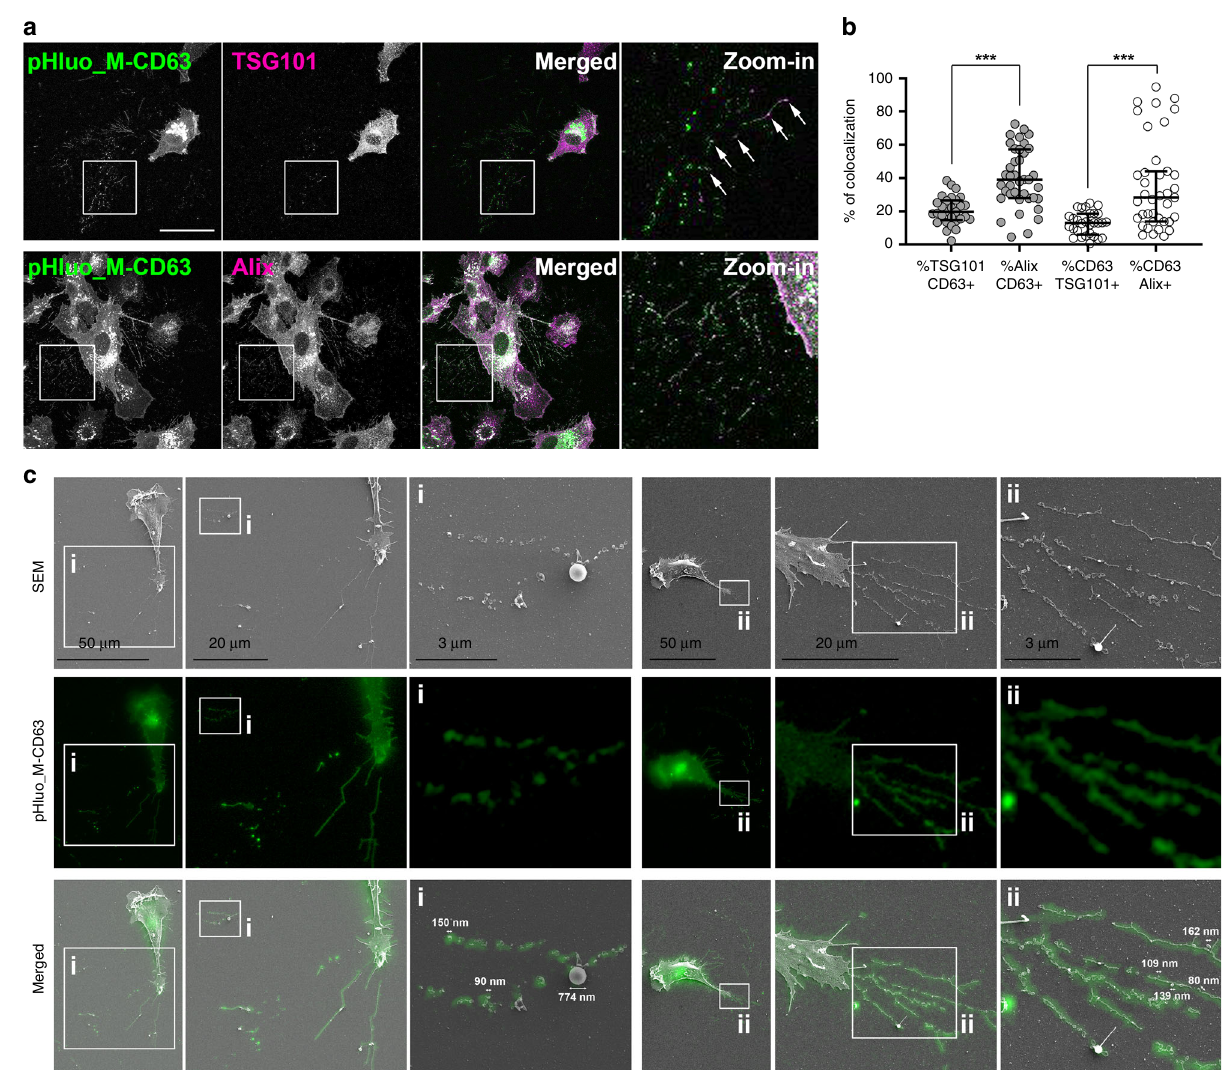
Fig. 3 pHluo_M153R-CD63-positive trails mark secreted exosomes. a Representative images of immuno fl uorescent staining of fi xed cells for the exosomal markers TSG101 or Alix (magenta) and pHluorin (green). Arrows indicate colocalization of TSG101 (magenta) with pHluo_M153R-CD63-positive puncta (green) to form white. Note many white puncta in the CD63 + Alix merged images. pHluo_M-CD63, pHluorin_M153R-CD63. n = 29 and 39 images for TSG101 and Alix, respectively, from four independent experiments. Scale bar, 30 µ m. b Colocalization analysis from ( a ) shown as a scatter-plot (median and quartile range). *** P < 0.001 by two-sided unpaired Mann − Whitney U test. c Correlative light-electron microscopy of pHluo_M153R-CD63-stably expressing HT1080 (green). Increasing magni fi cation of images is shown to the right and indicated with i or ii. Representative of 22 cells from four experiments. SEM scanning electron microscopy. Source data are provided as a Source Data fi